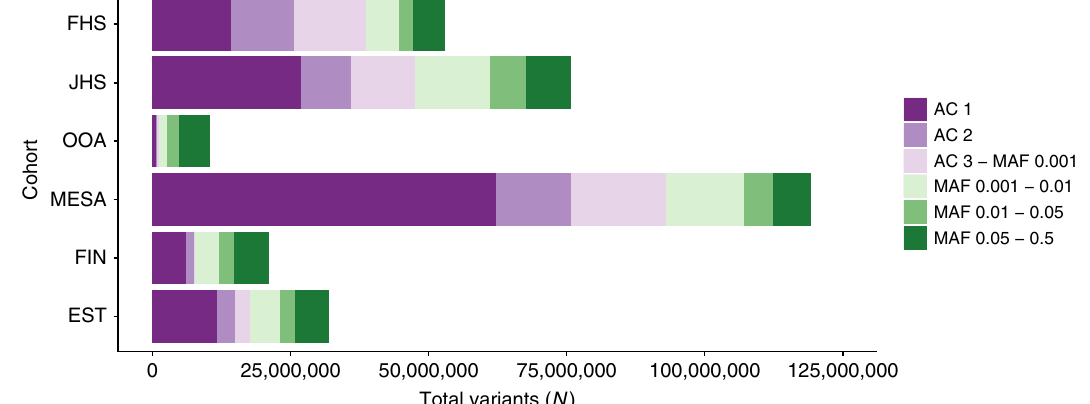
Fig. 2 Deep-coverage WGS identi fi es genomic variation across the allelic spectrum. Variant counts by allele count/frequency bin within each of the cohorts. Singletons ( “ AC 1 ” ) and doubletons ( “ AC 2 ” ) are separately distinguished from allele frequency bins within each cohort. Variants were jointly discovered in three distinct sets: (1) FHS, JHS, and OOA; (2) MESA; and (3) EST and FIN. AC allele count, EST Estonia, FHS Framingham Heart Study,